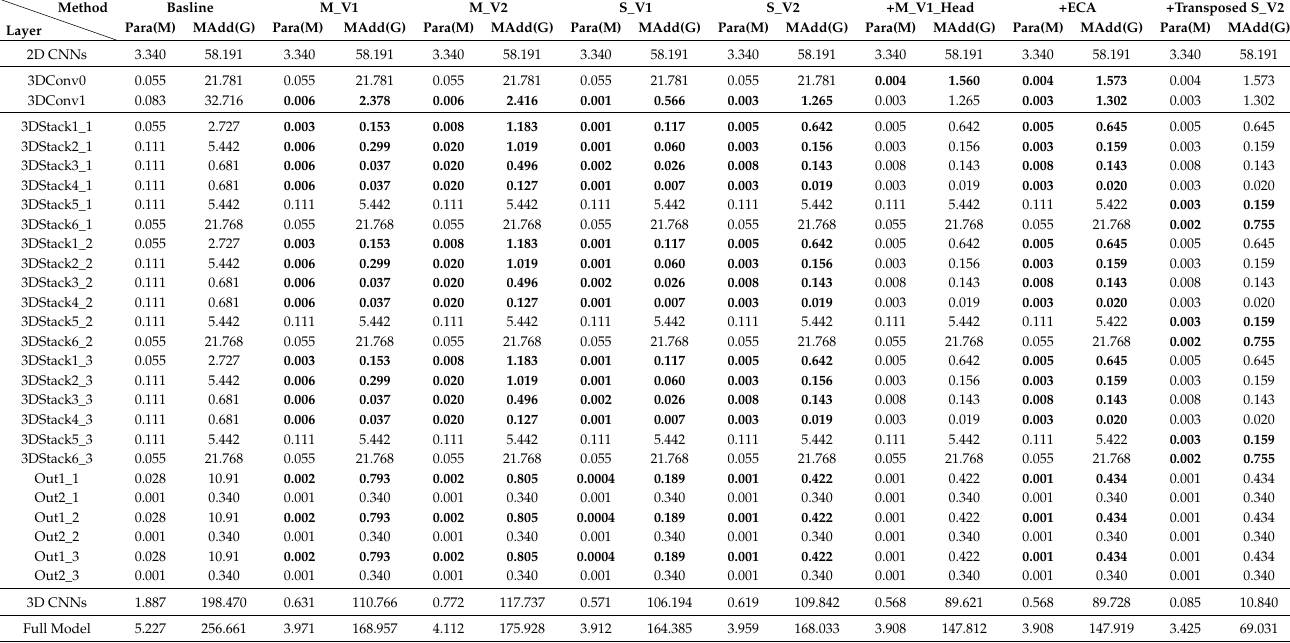
Table A2. Parameterize model details on all 3D convolution kernels in our network design pipeline. The numbers in bold denote the modified layers compare to former